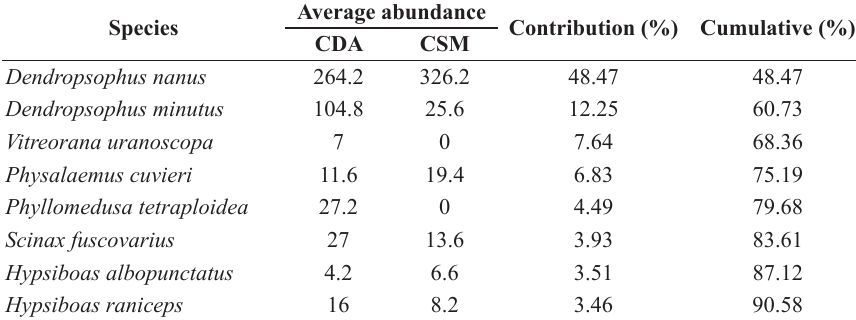
sIMPEr analysis for the species of anurans recorded in the areas CDa and CsM, located in the mid northern region of the state of Paraná, between september 2011 and March 2012, with values of average abundance, of total contribution to dissimilarity between areas and of accumulation of the contribution values.